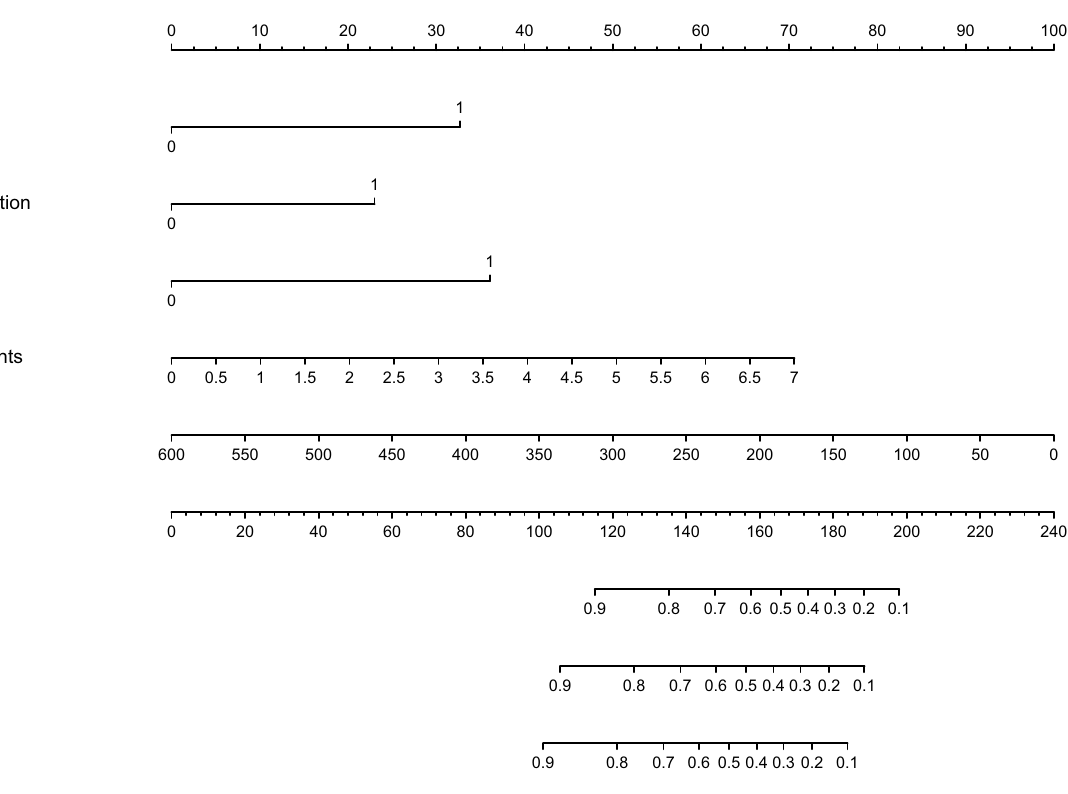
Figure 5. Nomogram predicting mortality in malignant patients with GNB. The nomogram was applied by adding up the points identified on the points scale for each variable. The total points projected on the bottom scales indicate the probabilities of 7-days, 15-days and 30-days OS. ICU represented admission to ICU before infection; pulmonary.infection meant that primary infection before GNB was pulmonary infection; shock meant that the patients got shock after GNB; Lymphocyte. counts meant lymphocyte counts(*10 9 /L); and Platelet. Counts meant platelet counts(*10 9